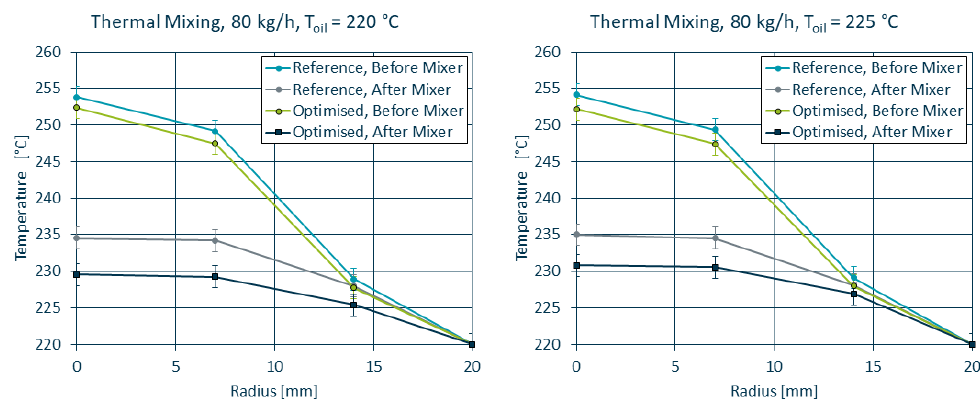
Figure 14. Temperature profiles of the reference and optimised geometries for both oil